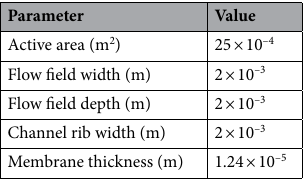
Table 1. Geometric parameters of the tested cell.